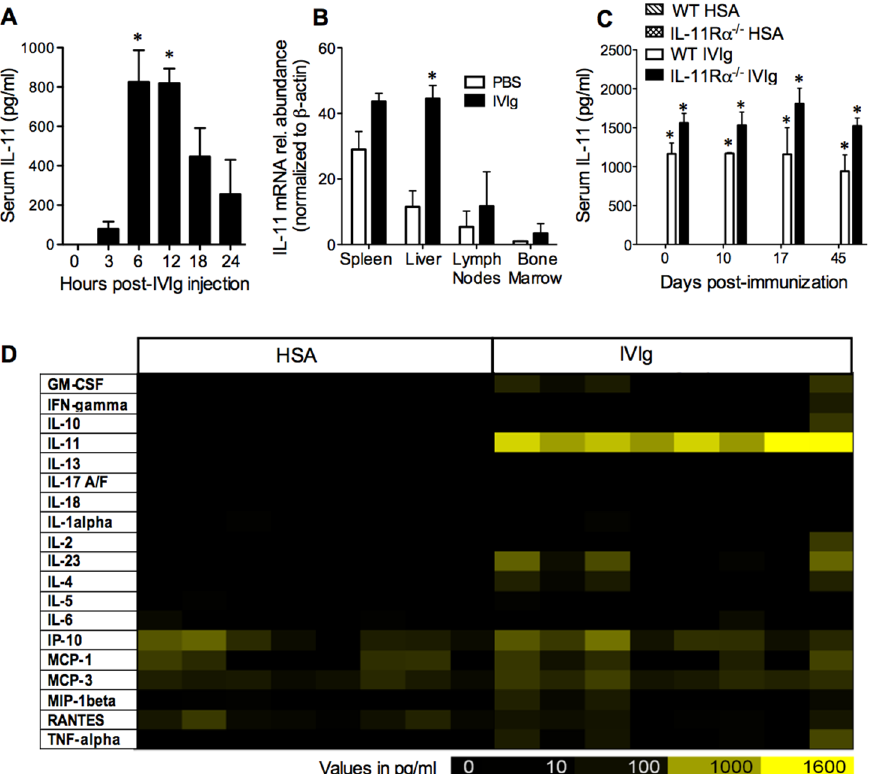
Figure 2. IVIg treatment induces a profound increase in the circulating levels of IL-11 in mice. A,B , Individual C57BL6/J mice were administered IVIg (2.0 g/kg) or PBS. A , Serum was collected for IL-11 protein measurement using ELISA at 0, 3, 6, 12, 18 and 24 hours post-injection. *indicates a significant difference (*p , 0.05) from time zero as determined using a one-way ANOVA and a Tukey post-hoc test. B , Tissues (spleen, liver, bone marrow, and pooled axillary and inguinal lymph nodes) were collected from mice at 6 h post-injection, total RNA was isolated and was reverse- transcribed to cDNA, and IL-11 mRNAs were measured in samples using real-time qRT-PCR. Shown is the abundance of IL-11 mRNAs (normalized to beta-actin) and expressed as fold-change relative to the comparator sample (bone marrow sample from PBS-treated mouse). *indicates a difference from PBS-injected group as determined using a Student’s t-test assuming equal variances (two-tailed, *p , 0.05). A&B show means + SEM of values obtained from individual mice. C , EAE was induced in C57BL/6J mice with MOG 35–55 /CFA and pertussis toxin. Mice were injected with IVIg or HSA daily (1 g/kg, i.p.). Shown are the IL-11 levels (pg/ml) in the sera of mice at 6 h post-injection on the day of onset (0), and at 10, 17, and day 45 post- immunization with MOG 35–55 and CFA. Values are means 6 SEM of readings from 2–5 individual mice/group/time point. *indicates a significant difference (p , 0.05) from the HSA-injected, genotype-matched counterpart. D , shows a heat map of serum cytokine/chemokine levels taken at 6 h post IVIg or PBS injection with N=8 mice/group. Each data box in the heat map represents a reading from an individual mouse.